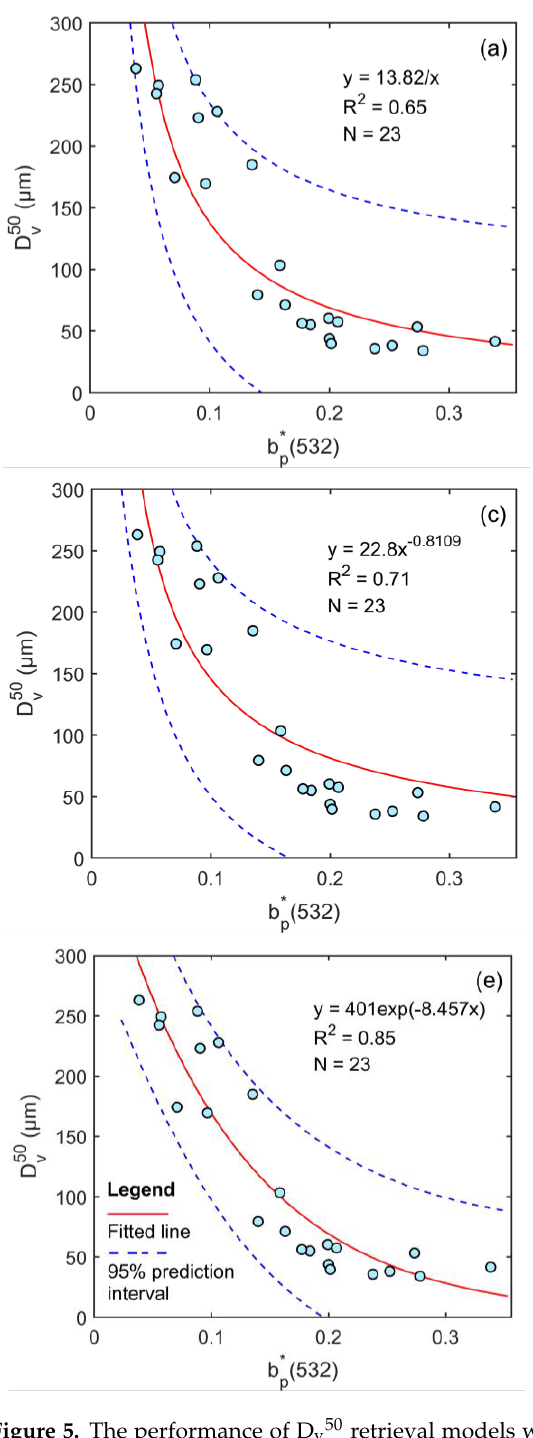
Figure 5. The performance of D v50 retrieval models with b p *(532) (( a ) inverse proportion, ( c ) negative power function, and ( e ) negative exponential function) and b bp* (532) (( b ) inverse proportion, ( d ) negative power function, and ( f ) negative exponential function).